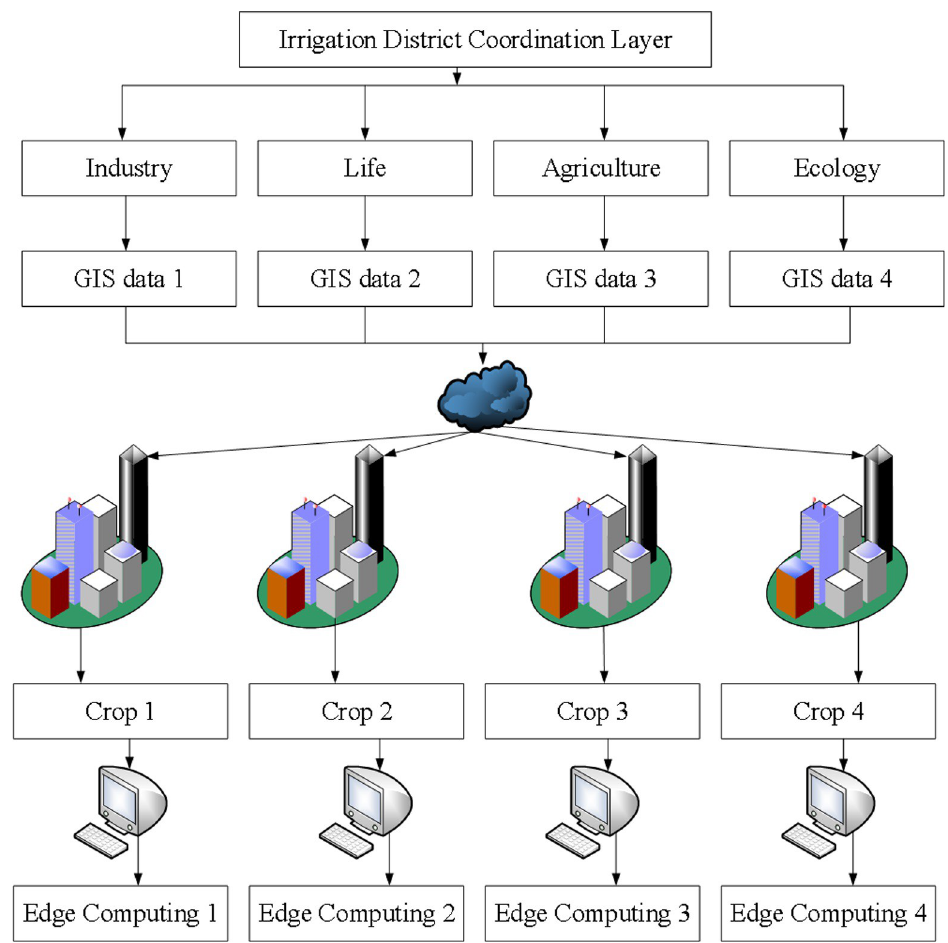
Fig 1. The optimal allocation plan of the water resource and water